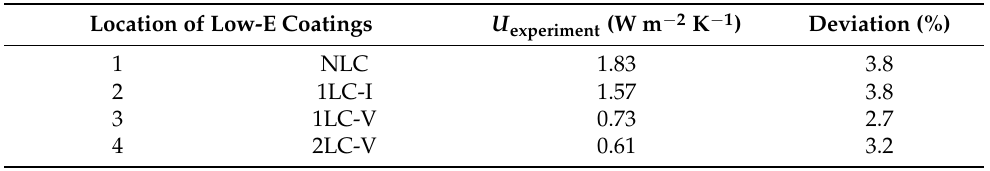
Table 7. U experiment test results and the deviation between U experiment and U tot calculated in the simulation